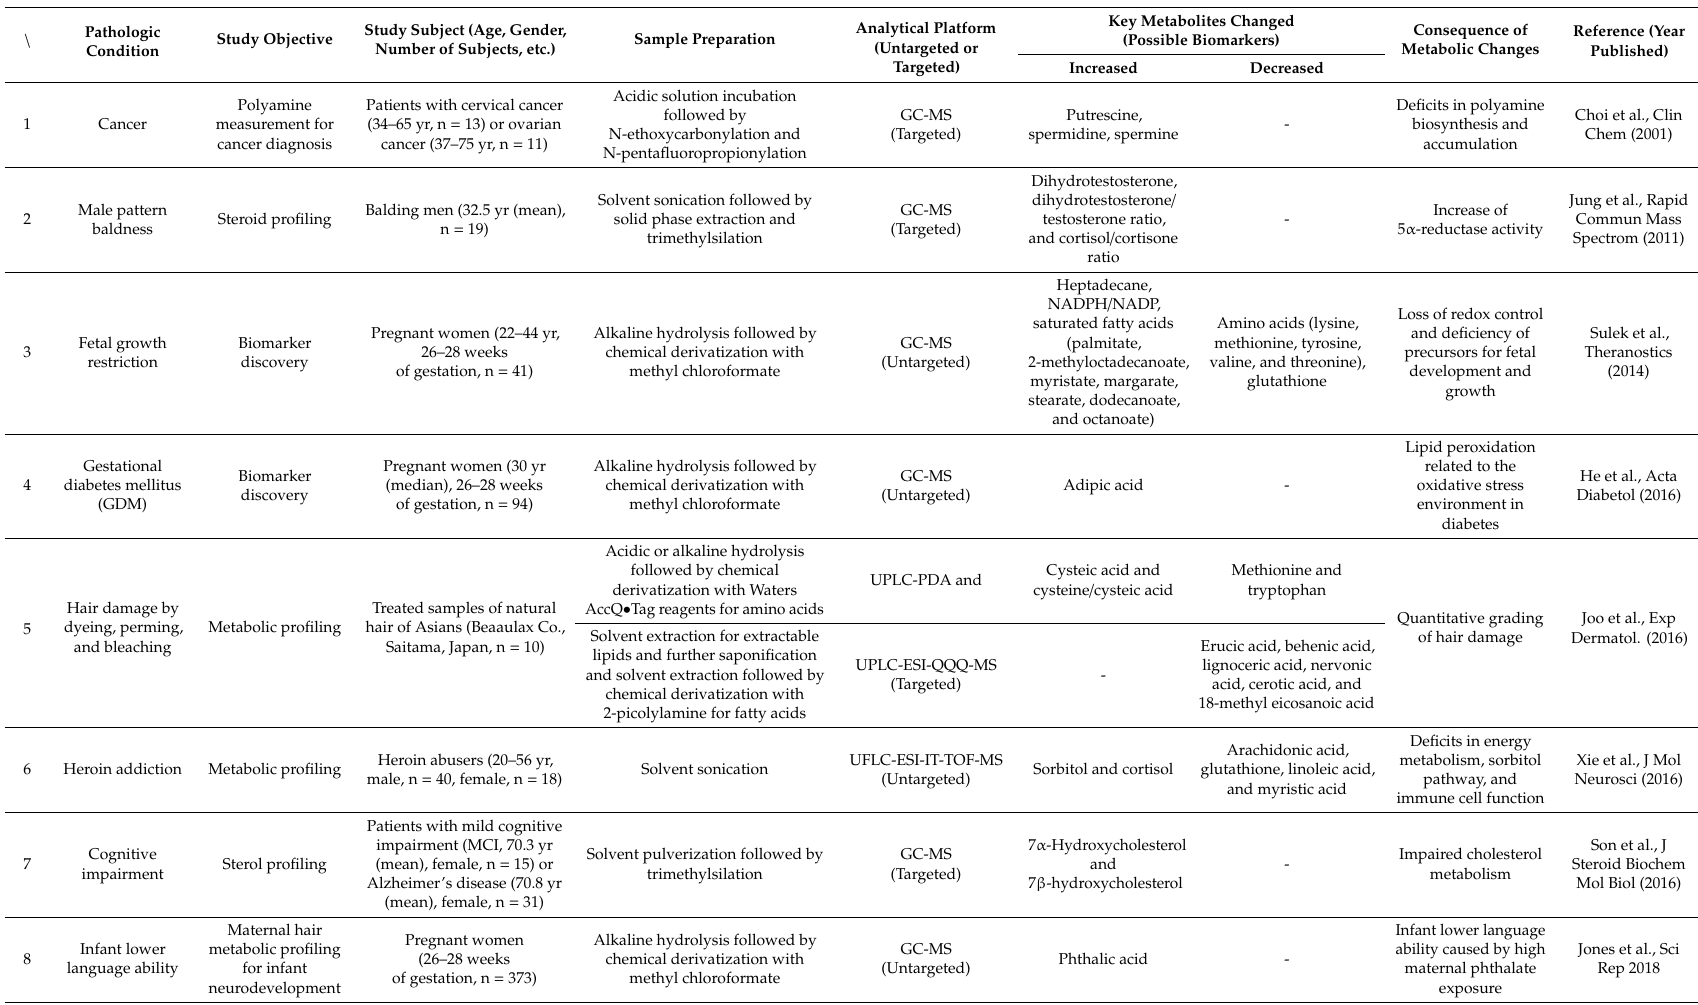
Table 2. Use of hair metabolomics in clinical